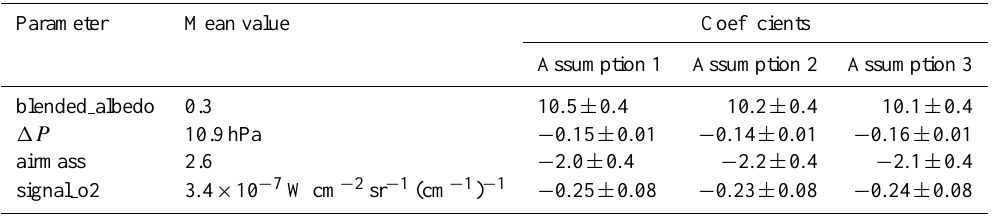
Table 2. Parameters and values for Eq. (4). The coefficients list the values for three assumptions of the X CO Hemisphere: 1, that there is a small seasonal cycle and a 1.89ppm/year secular increase (i.e., Eq. 4); 2, that there is only a 1.89ppmyr − 1 secular increase (i.e., no seasonal cycle); and 3, that there is a small seasonal cycle, a 1.89ppmyr − 1 secular increase, and a − 1ppm gradient between 25 ◦ S and 55 ◦ S. The errors are twice the bootstrapped standard errors. The coefficients have units ofppm/unit of blended albedo,ppm/hPa,ppm/airmass andppm/(10 7 Wcm − 2 sr − 1 (cm − 1 ) − 1 ),